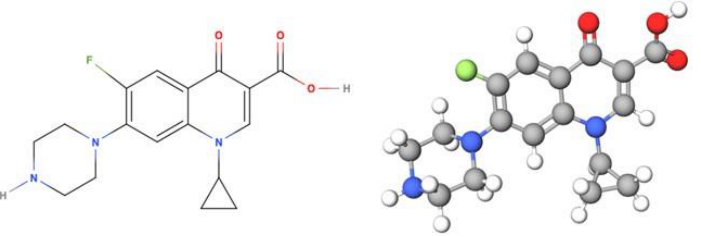
Figure 1. Structure of ciprofloxacin.